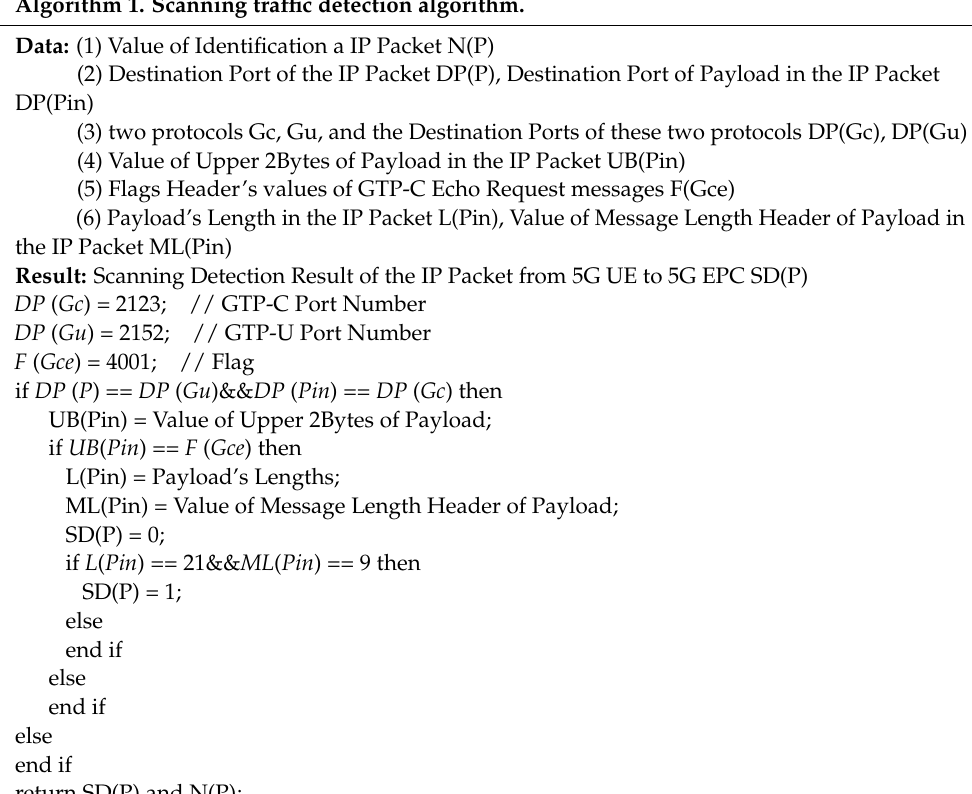
Algorithm 1. Scanning traffic detection algorithm.